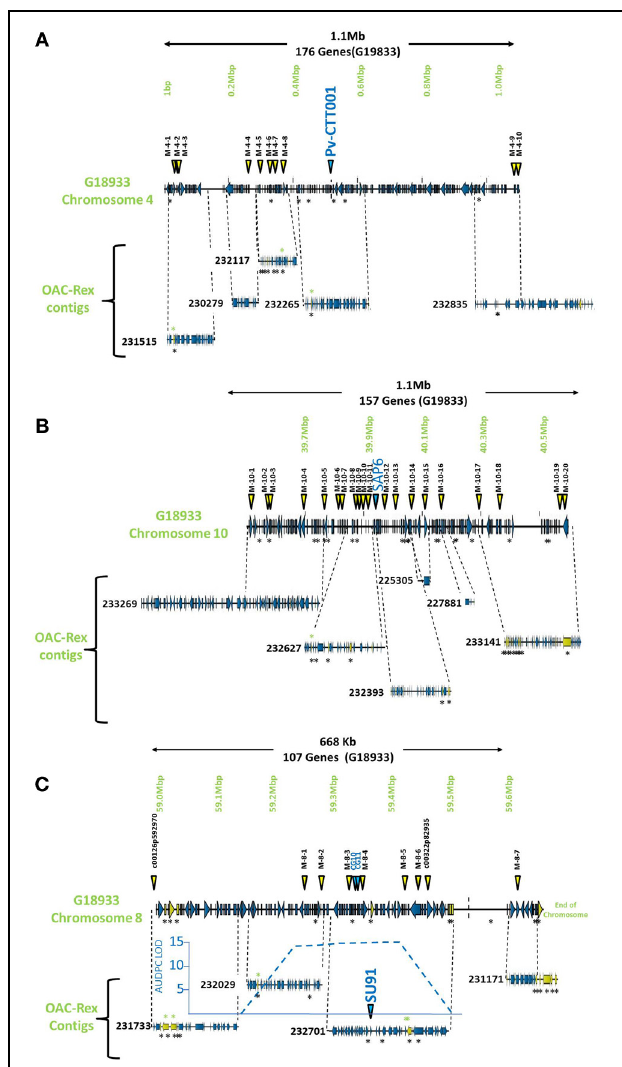
FIGURE 1 | Comparison of genomic regions in G19833 and OAC-Rex surrounding the CBB-associated molecular markers. The OAC-Rex contigs are positioned relative to the G19833 sequence from chromosome 4 (A) , 10 (B), and 8 (C) , encompassing the Pv- CTT001, SAP6, and SU91 markers, respectively. The locations of Pv- CTT001, SAP6, and SU91 are denoted by purple triangles, while the locations of the SNP markers are indicated with yellow triangles. The locations of unique genes are indicated by the presence of black asterisks ( ∗ ) under the sequences. Unique genes from OAC-Rex with homology to P. acutifolius ESTs are indicated by green asterisks above the contigs. For the chromosome 8 figure, the positions of two additional gene-based markers (CG10 and CG11, Shi et al., 2012) are also denoted by purple triangles. Additionally, the location of the identified CBB-QTL from the region surrounding the SU91 marker in a OAC-Rex X Sanilac population is indicated by the embedded chart, normalized to the markers on chromosome 8 (Xie et al., unpublished